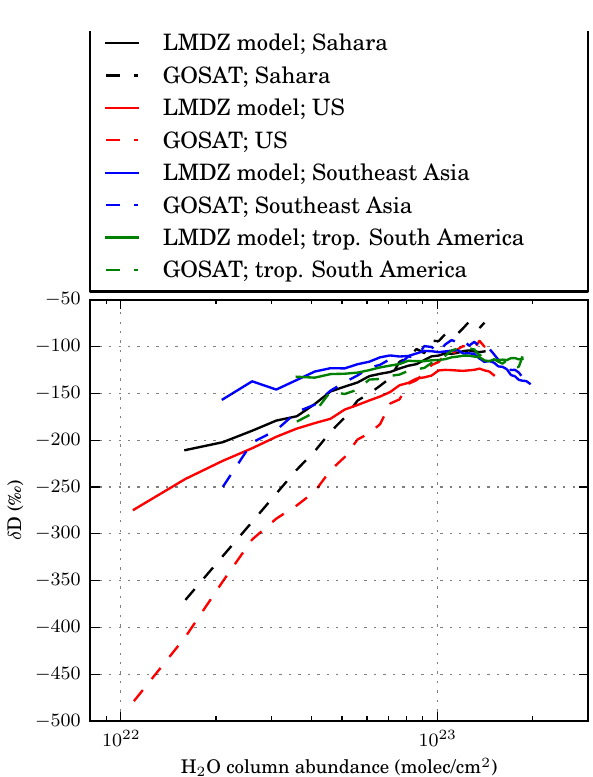
Fig. 9. Average Rayleigh curves for land-only data of LMDZ and GOSAT over the Sahara (15 ◦ N–25 ◦ N, 5 ◦ W–20 ◦ E), continental US (30 ◦ N–50 ◦ N, 125 ◦ W–75 ◦ W), Southeast Asia (7 ◦ S–28 ◦ N, 70 ◦ E–120 ◦ E) and tropical South America (20 ◦ S–5 ◦ N, 120 ◦ W– 40 ◦ W). The bottom panel shows the deviations from the average Rayleigh curve of all four regions (restricted to vapor abundances observed in all